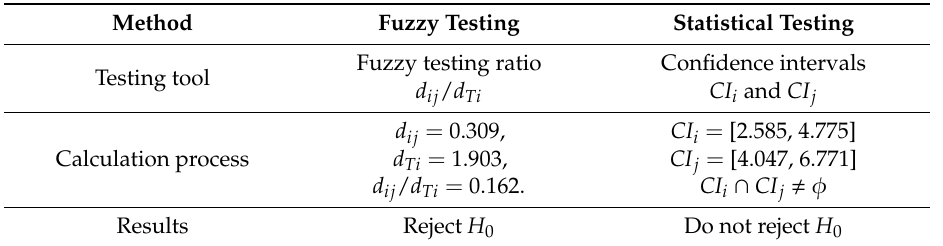
Table 1. Comparison table of